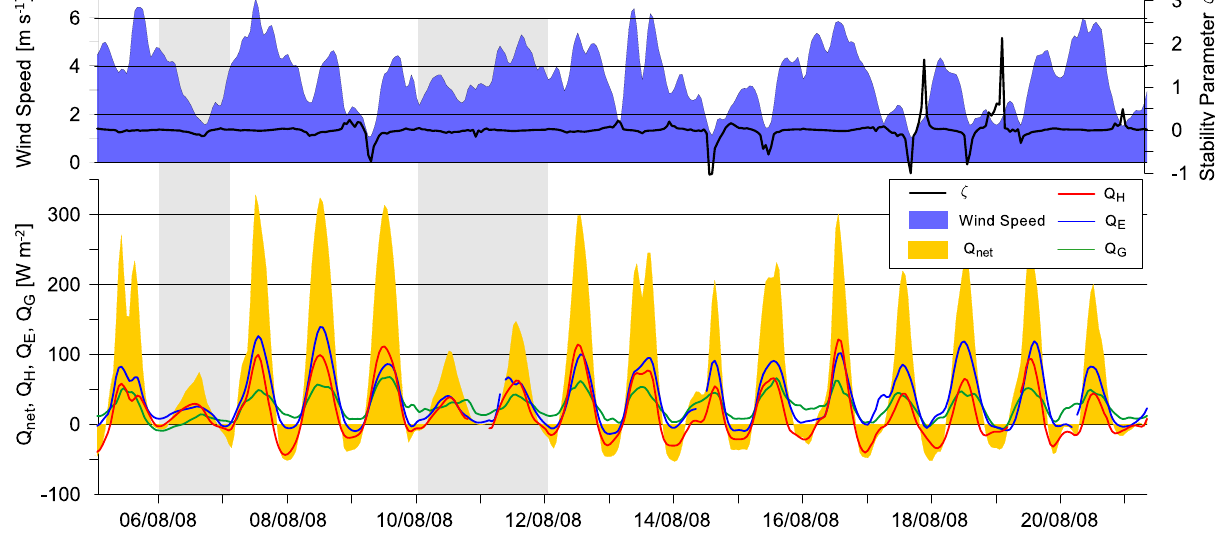
Fig. 6. Sample heat fluxes, wind speed, and stability parameter during late summer 2008, with overcast periods marked in